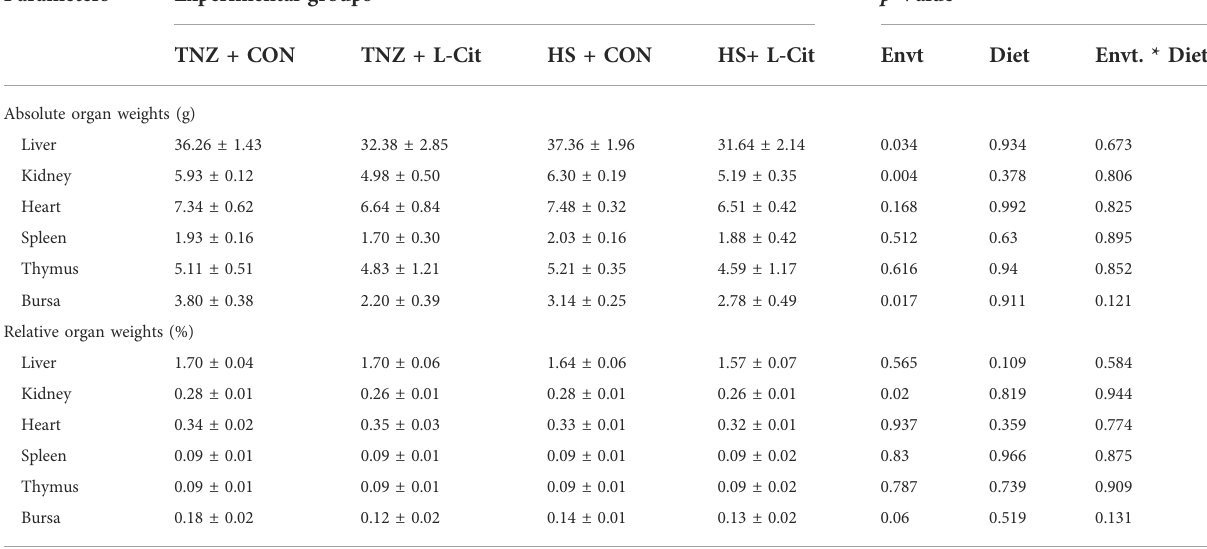
TABLE 4 Effects of heat stress and L-citrulline supplementation on organ indexes of broiler chickens. Parameters